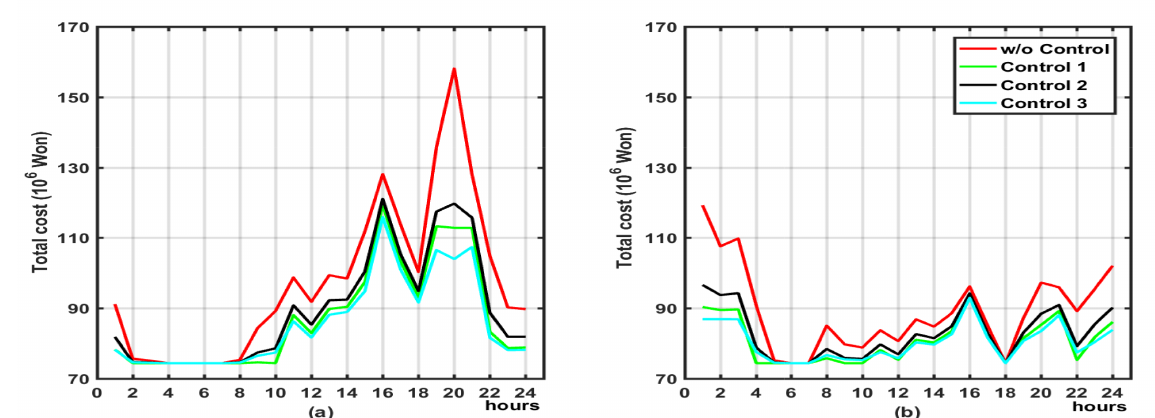
Figure 10. Total costs of EV controls in: ( a ) Case 1 and ( b ) Case